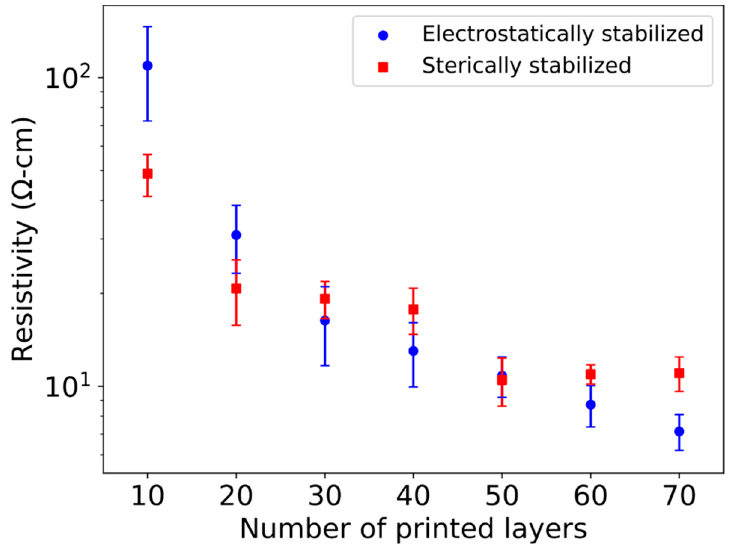
Figure 9. Resistivity of lines of highly loaded, sterically stabilized (blue) and electrostatically stabi- lized (red) MGNS inks printed onto a gloss photo paper substrate.